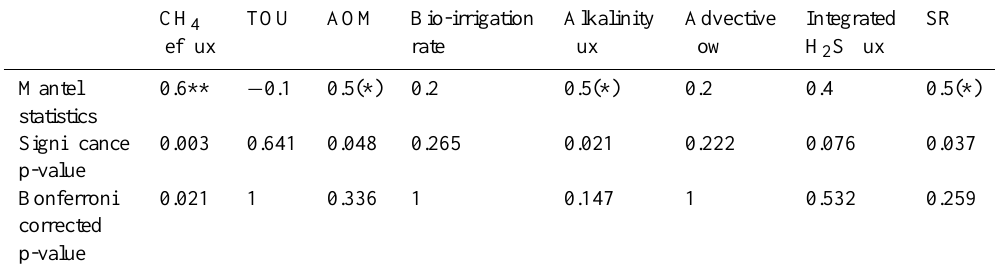
Table 5. Mantel test, checking for correlation between β -diversity (calculated as Bray-Curtis dissimilarities) and difference in CH 4 efflux, Total Oxygen Uptake (TOU), integrated Anaerobic Oxidation of Methane (AOM) and Sulphate Reduction (SR) rate, alkalinity flux, advective flow, integrated sulphide flux and bio-irrigation rate. The spearman rank coefficient was used for calculating correlations. * = p < 0 . 01; Bonferroni correction was applied to correct for multiple testing. (*) only significant without Bonferroni correction. Mantel correlation test was performed on pooled ARISA samples (0–10cm depth) according to habitat. For this analysis data from the following sites was